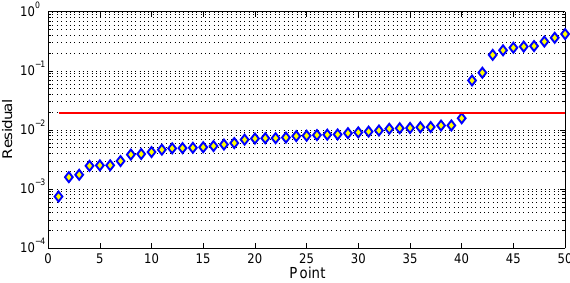
Figure 3: Residuals at the last iteration of FS arranged in ascend- ing order. The red horizontal line is the threshold that has been